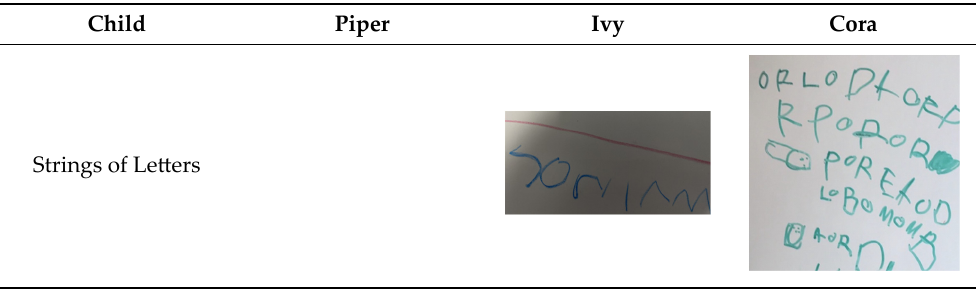
Table 2. The Emergent Stage.